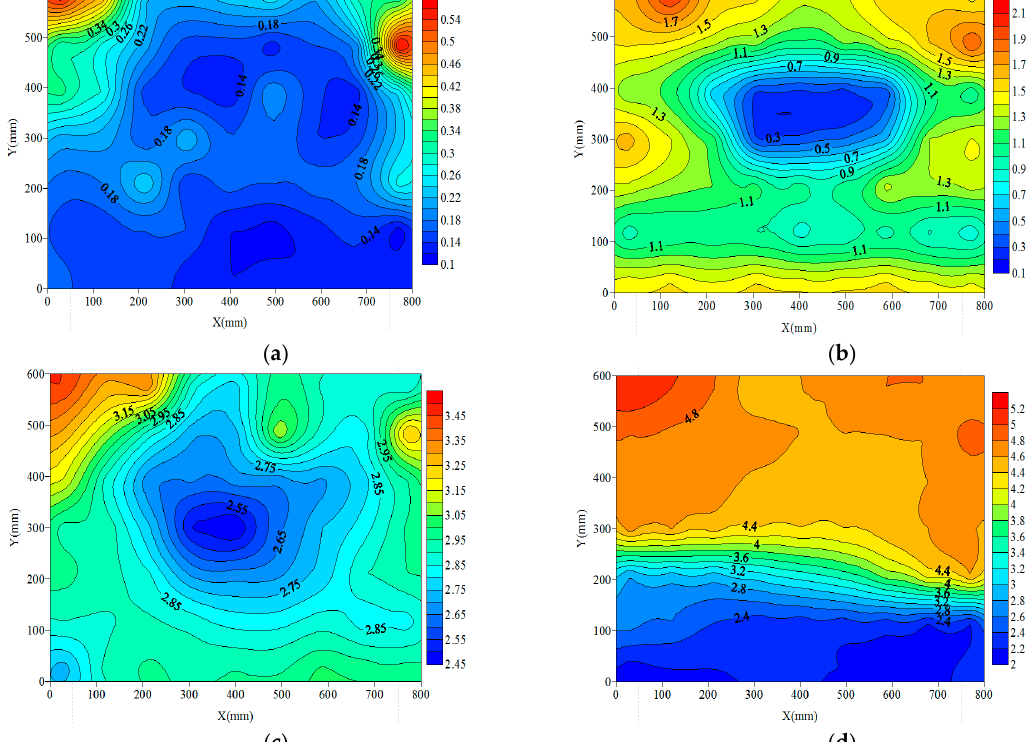
Figure 5. Contour map of the dissolved oxygen distribution in the main reaction zone at each aeration amount. ( a ) 0.10 m 3 /h (Unit: mg/L), ( b ) 0.20 m 3 /h (Unit: mg/L), ( c ) 0.30 m 3 /h (Unit: mg/L), ( d ) 0.40 m 3 /h (Unit: mg/L).